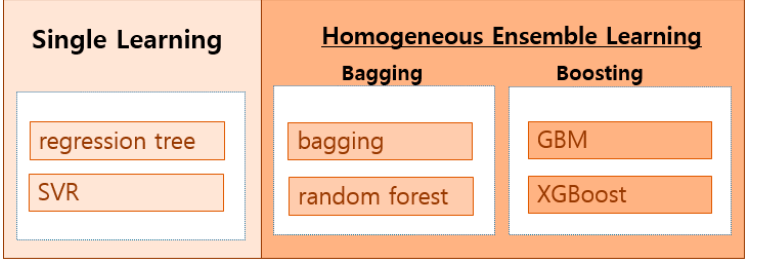
Figure 3. Machine learning algorithms. Abbreviations: SVR, support vector regression; GBM, gradient boosting machine; XGBoost, extreme gradient boosting.